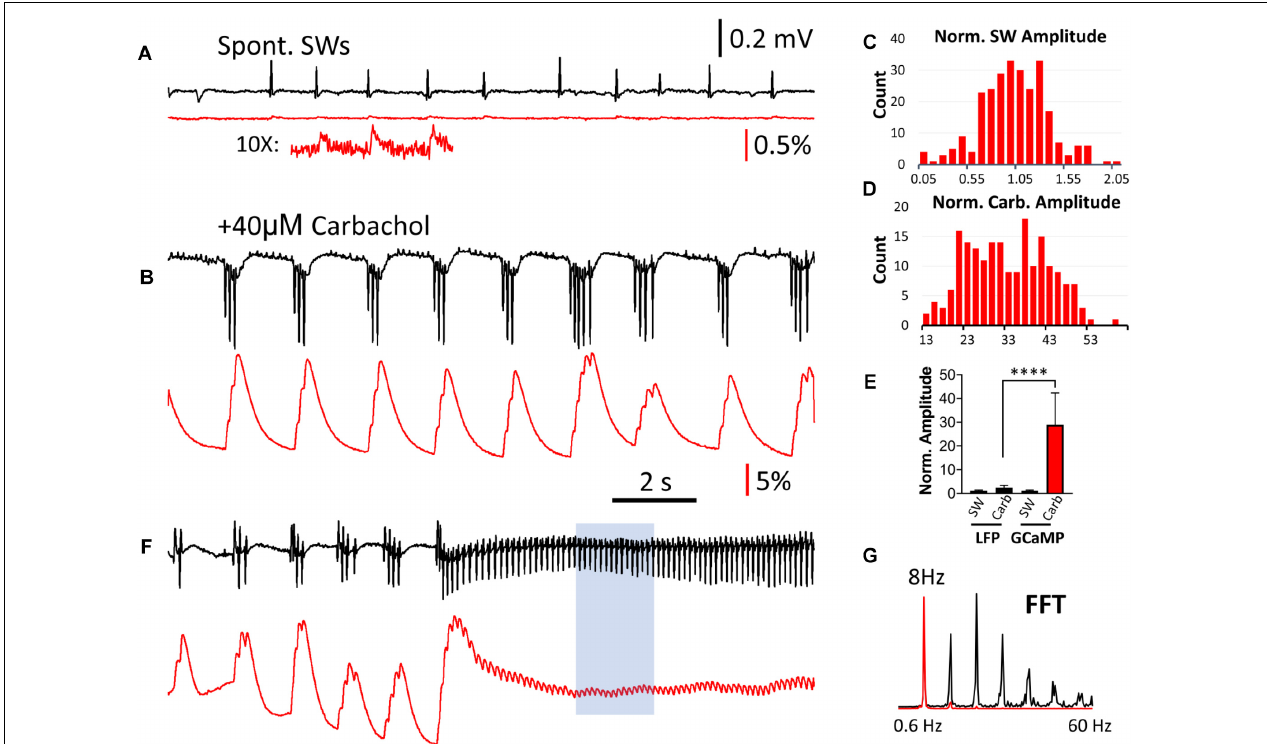
FIGURE 5 | Comparison of LFP and GCaMP signals during carbachol-induced theta oscillations. (A) Spontaneous SWs when the slice is bathed in normal ACSF, compared with (B) Induced theta bursts recorded from the same tissue after bath administration of 40 µ M of the cholinergic agonist carbachol. The LFP and GCaMP signals are drawn on the same scales for panels (A,B) . On this amplitude scale the GCaMP SW events are very small, but can be clearly seen with 10 × amplification ( A , Inset). Note that the polarity of the LFP signals were reversed during theta bursts, and a group of three or more spikes in the LFP was merged into a single large peak with GCaMP. (C) Amplitude distribution of SWs in the GCaMP signals ( n = 260 SWs, four slices from four animals), first normalized to the average amplitude from each slice and then pooled together in the distribution chart. (D) Amplitude distribution of carbachol-induced theta bursts in GCaMP signals ( n = 252 bursts, four slices from four animals). The amplitude was normalized to the average SW amplitude in each slice. Note that the majority of bursts were 13–30 times larger than the SW in the same tissue. (E) Amplitude discrepancy: When LFP and GCaMP signals during bursts were normalized to the average amplitude of SWs in the same tissue, The increase in GCaMP was 28.9 (SD 13.5, n = 252 bursts, four slices from four animals) while the LFP was only 2.37 (SD 1.02, n = 252 bursts, four slices from four animals). Significant difference in medians from the Kruskal-Wallis test, p < 0.0001 (Dunn’s multiple comparisons correction between LFP and GCaMP during carbachol show p < 0.0001). Error bars indicate SD. (F) Continuous theta cycles developed with continued carbachol perfusion. These ∼ 8 Hz oscillations were seen in both LFP and GCaMP signals. (G) An FFT of a sub-section of this signal ( F , blue box) revealed a clear peak at 8 Hz in both the LFP and GCaMP6f signals, as well as higher